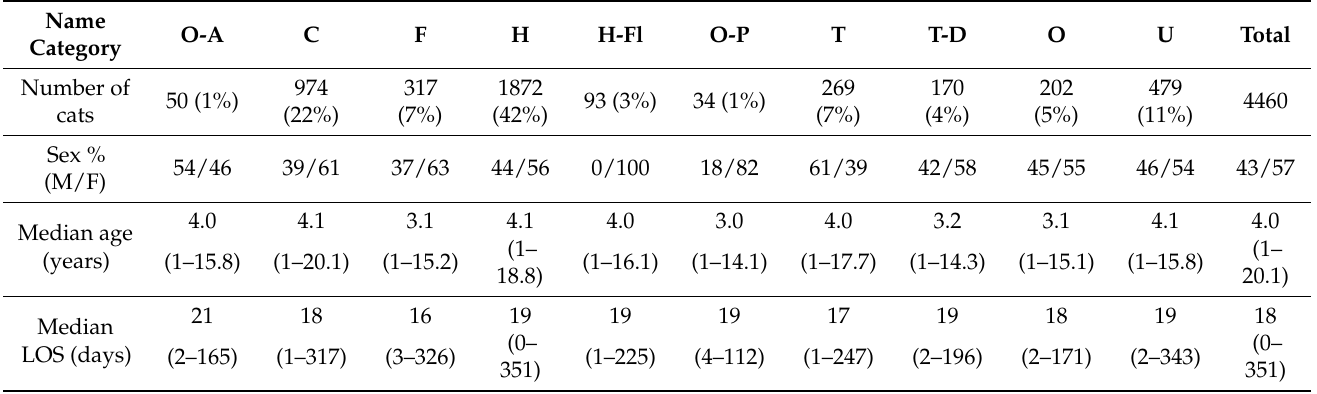
Table 4. Summary of results from retrospective name categorisation. Ten categories of names were created: animal names (O-A), cat names (C), food/drink (F), human names (H), flowers (H-Fl), plants (O-P), fictional character names (T), Disney TM names (T-D), other/miscellaneous names (O) and unusual/uncommon names (U). Category of name was not found to significantly affect the mean length of stay (LOS) in the univariate model ( p = 0.198).